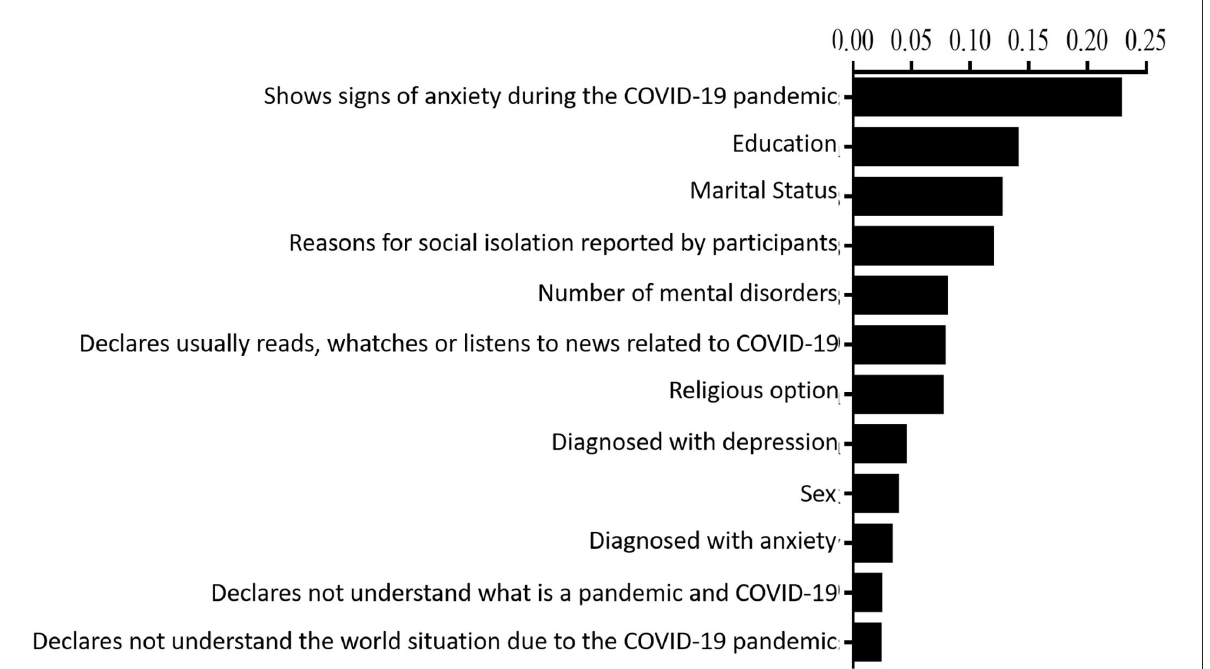
FIGURE2 Importance of the variables for the characterization of the groups with and without depression. The figure shows the percentage importance of each variable that has statistical